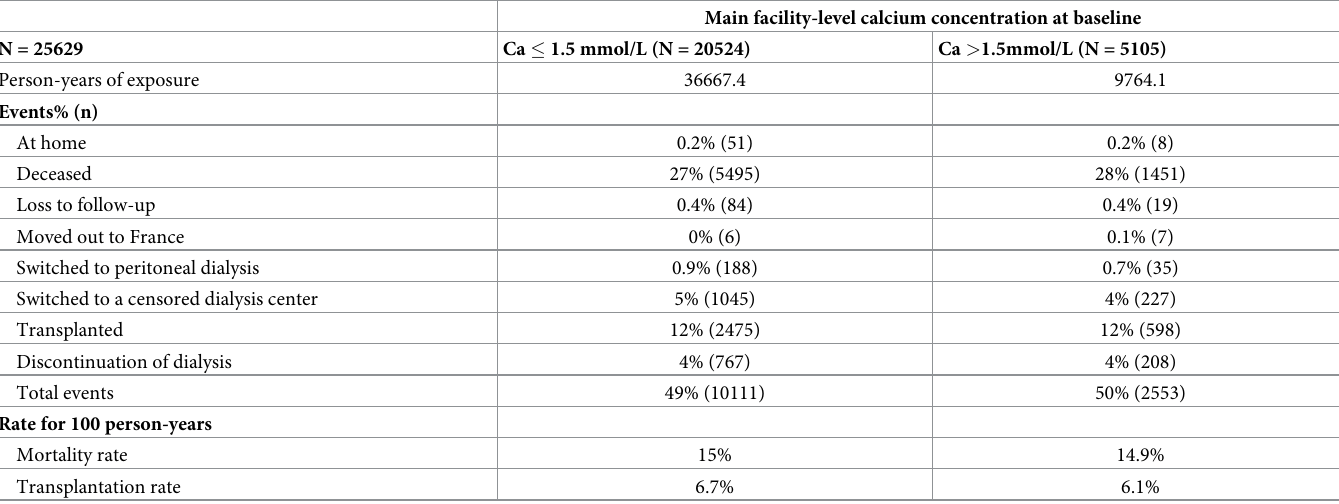
Table 6. Person-years of exposure and percentages of events, by dialysate group at